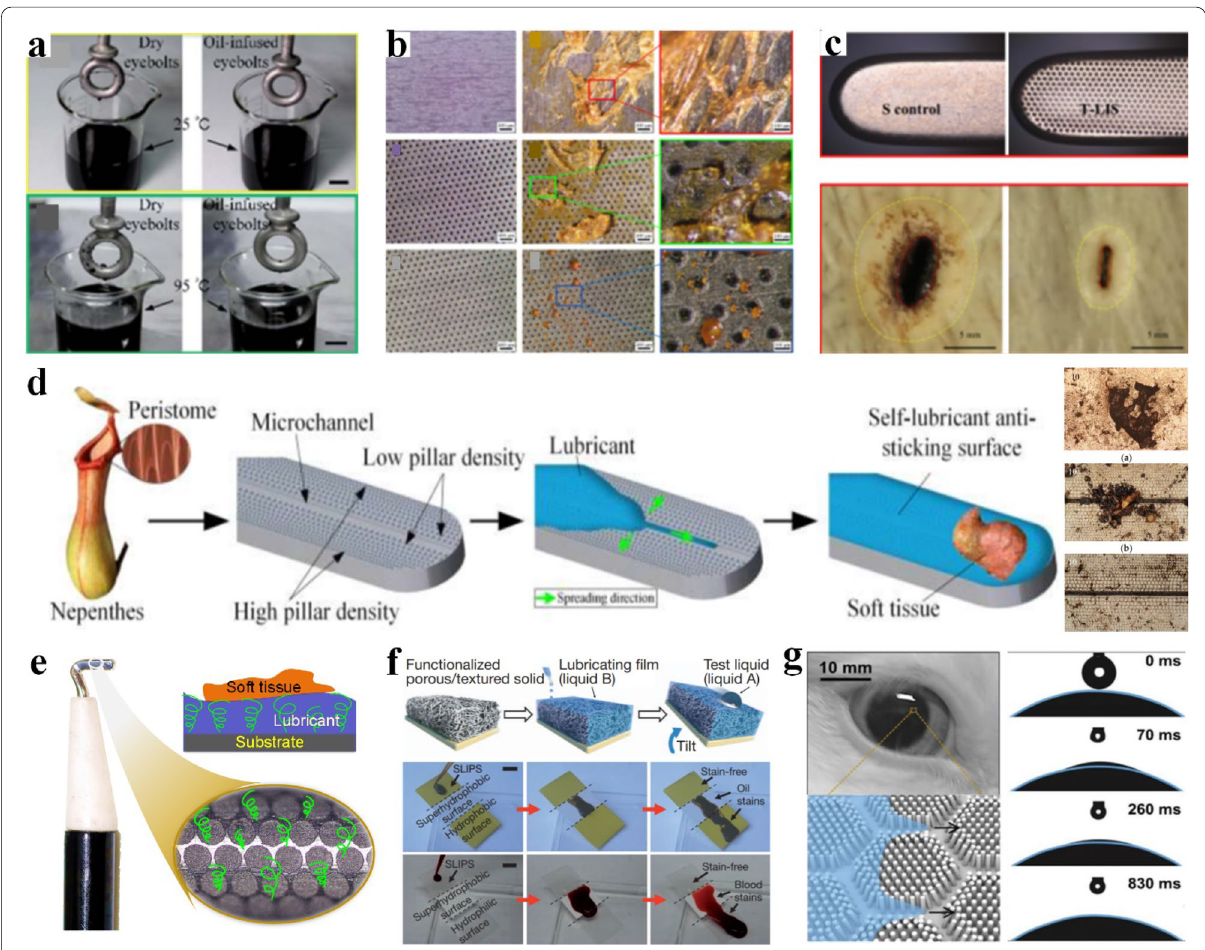
Figure 6 Liquid-infused slippery strategies for anti-adhesion on surgical scalpels: ( a ) stable liquid-infused slippery surface, ( b ) liquid-infused textured surfaces on stainless steel, ( c ) liquid-infused textured surfaces for low damage effects, ( d ) self-lubricating slippery anti-adhesion surface, ( e ) slippery surface on electrocautery instrument for the anti-adhesion of soft tissue, ( f ) stable and self-lubricating slippery liquid-infused porous surface, and ( g ) enhanced rapid super-spreading